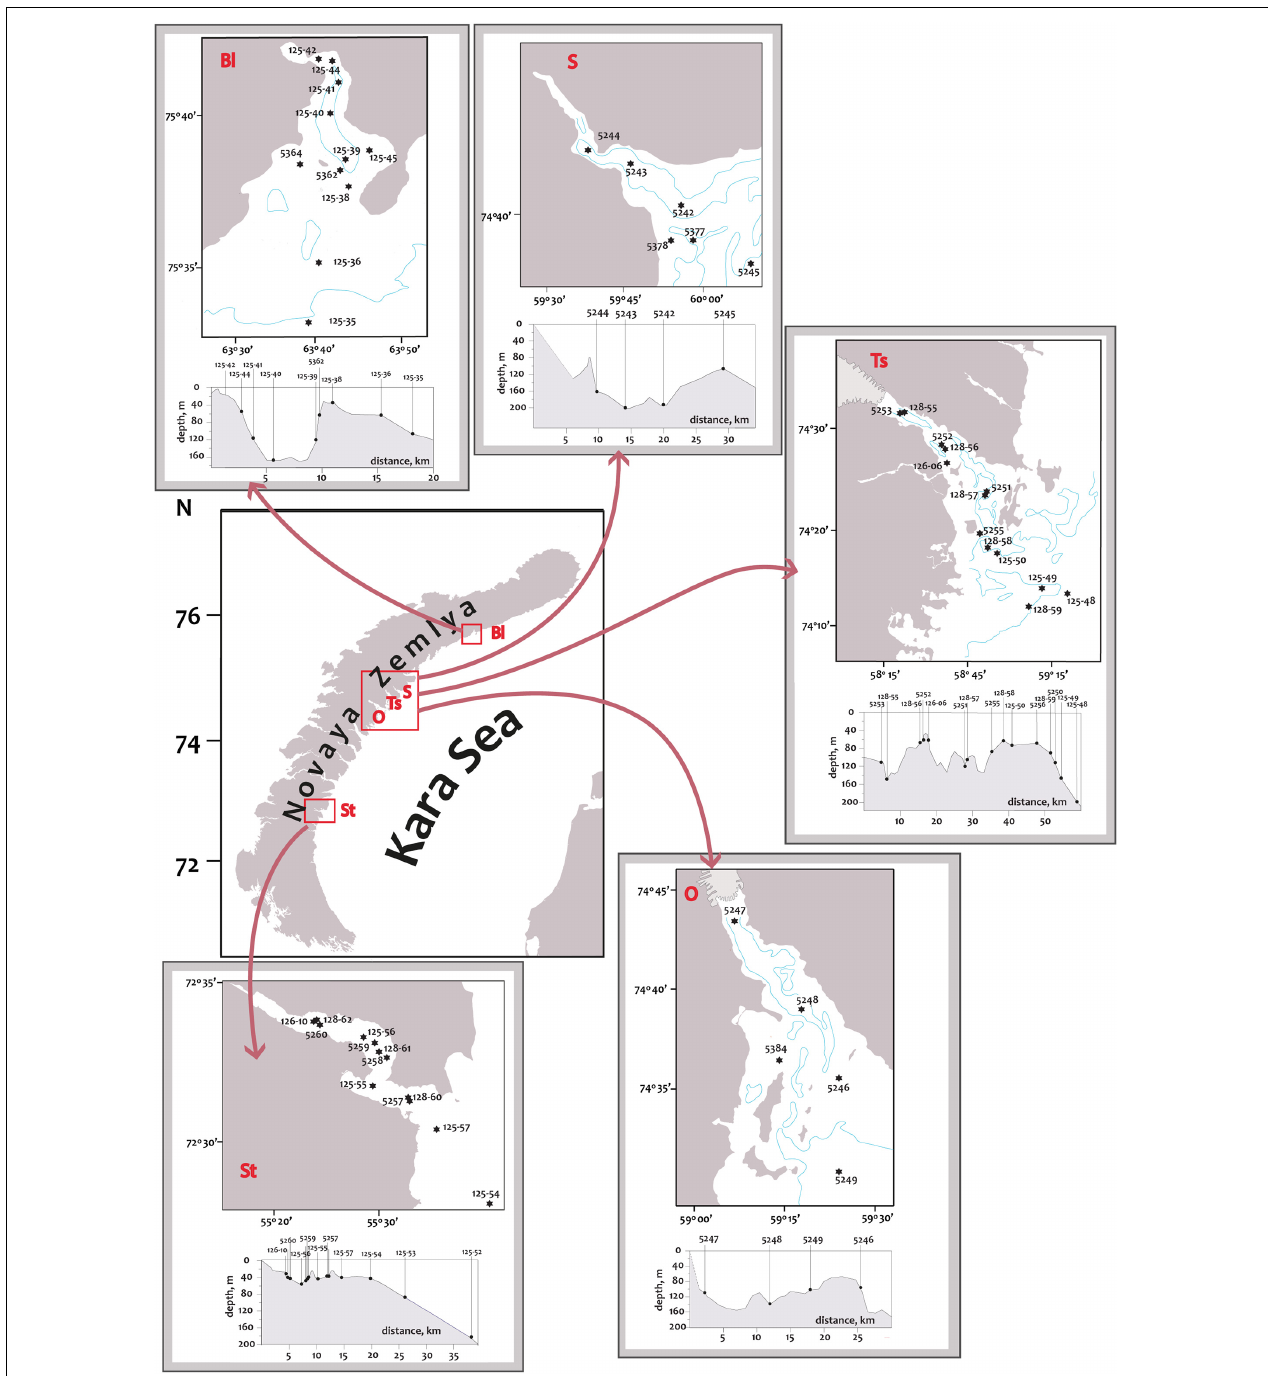
FIGURE 1 | Map of the Novaya Zemlya archipelago illustrating the location of Blagopoluchiya Bay (Bl), Sedova Bay (S), Tsivolki Bay (Ts), Oga Bay (O), Stepovogo Bay (St). The sampling sites are highlighted by red squares. The locations of sampling stations in the fjords are marked with filled circles. The 100 m isobath is marked with a blue line. The small inserts show the bathymetric profiles with the designation of each station.